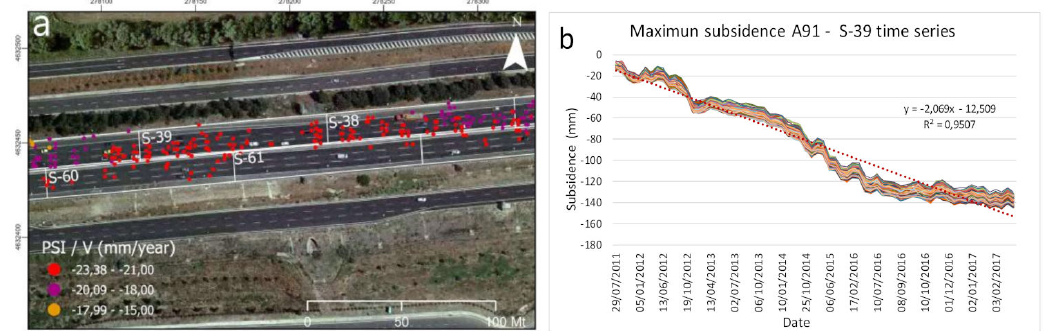
Figure 15. ( a ) Detail of the subsidence area of the A91 highway as background orthophoto Rome 2011. ( b ) Graph of the time series of section S-39.